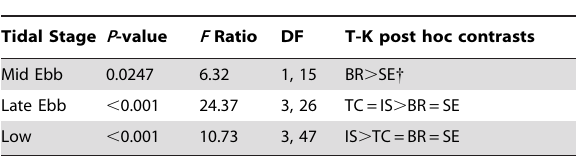
Table 2. Results of one-way ANOVAs comparing mean shorebird densities among tidal flats, as a function of tidal